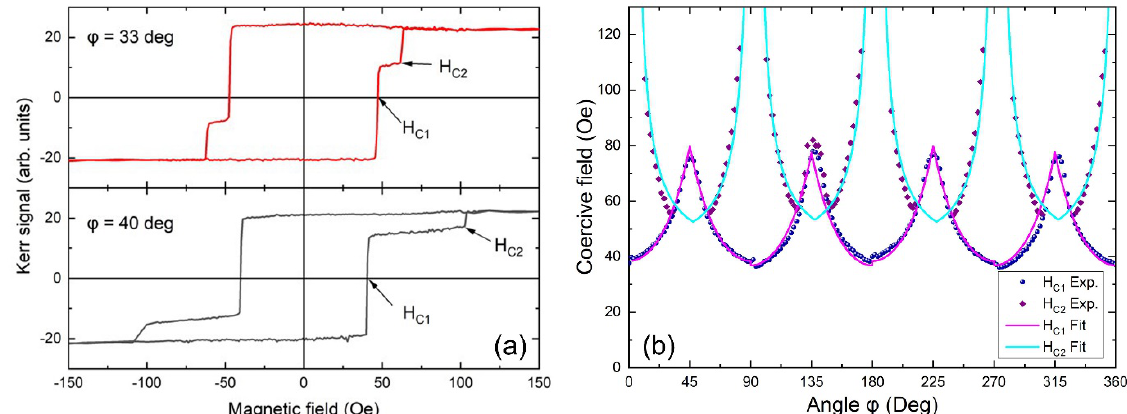
Figure 5. L-MOKE characterization: ( a ) Hysteresis loops with two steps at switching fields H C1 and H C2 indicative for two ϕ angles, where ϕ is the angle between the applied magnetic field and the easy magnetization [100] axis of Fe. ( b ) Coercive fields H C1 and H C2 plotted against the angle ϕ (data points) and fittings (lines) according to Equation (1). The excellent quality of the fittings indicates the validity of the model of Equation (1).